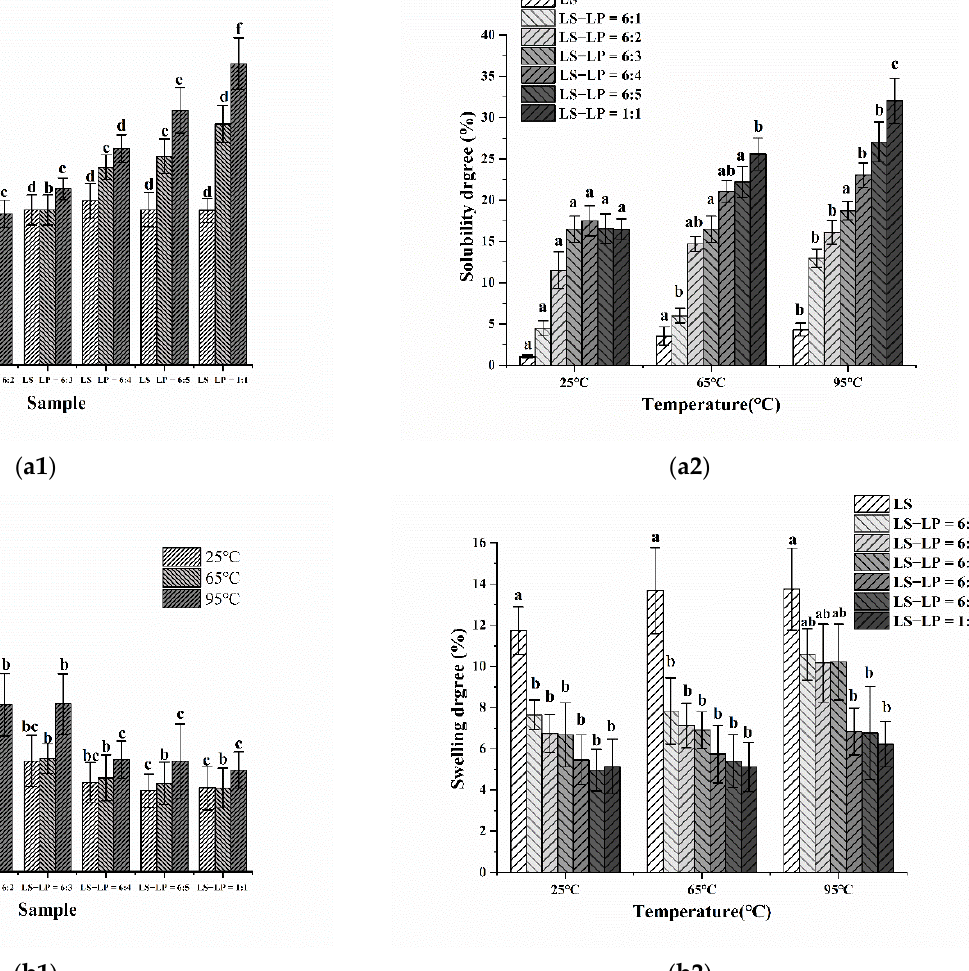
Figure 8. The solubility (a) and swelling (b) degree of lotus seed starch–protein mixture at different temperatures ( a1 , b1 ) (25 °C, 65 °C, 95 °C) and different samples at the same temperature ( a2 , b2 ). Note: LS indicates lotus seed starch. LS-LP = 6:1–5 or 1:1 indicates lotus seed starch–protein with different ratios. Mean values with different superscript in a same temperature (a1,b1) and same ratio ( a2 , b2 ) are significantly (p ≤ 0.05) different from each other.